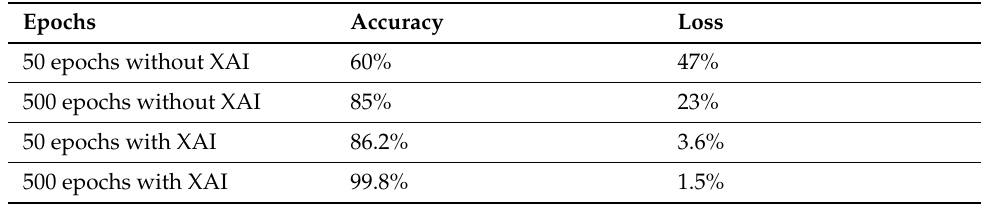
Figure 7. Comparison of Eli5 and LIME XAI models. ( a ) Eli5 Model. ( b ) Lime XAI Model. Table 4. Accuracy and loss comparison of